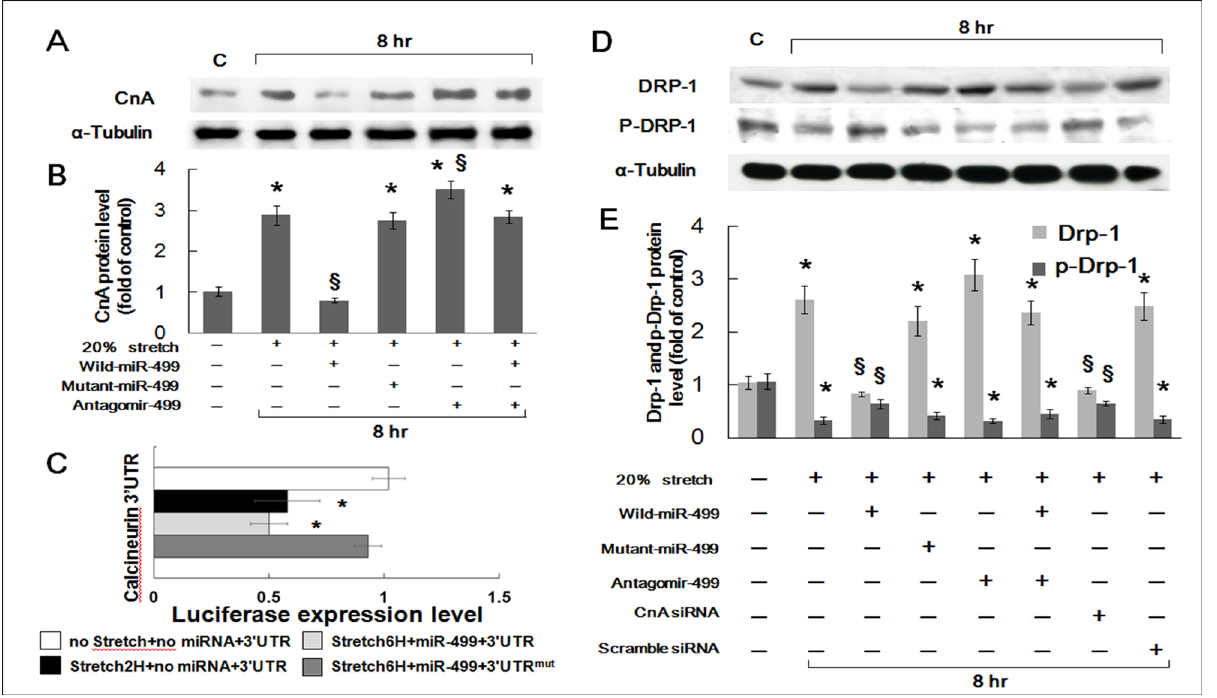
Fig 2. (A and B) Representative Western blot and quantitative analysis for the expression of CnA in cardiomyocytes subjected to 20% stretch for 8 hours with the overexpression of miR499, mutant miR499, or antagomir499 (n = 4 per group). (C) The miR-499 binding site in the 3 0 UTR of CnA mRNA specifically mediated miR-499-dependent repression in luciferase assays. (D) Representative Western blot for dephosphorylated (Drp-1) and phosphorylated Drp1 (p- Drp1) protein in cardiomyocytes subjected to stretch at 20% elongation for 8 hours with the overexpression of miR499, mutant miR499, antagomir499,